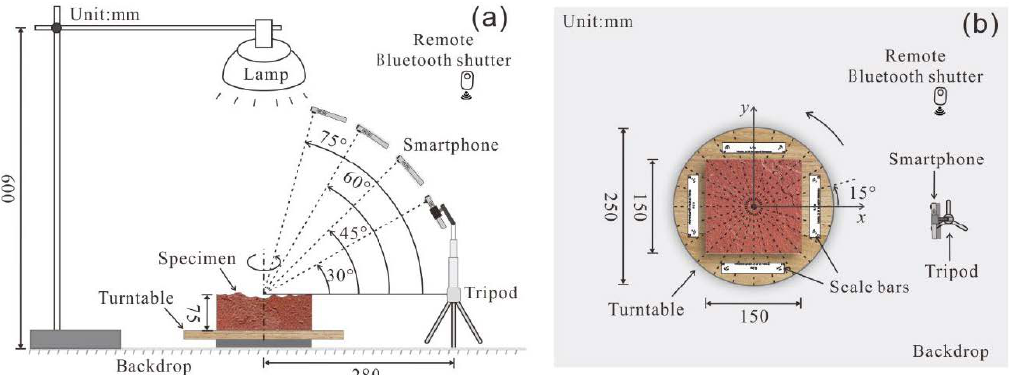
Figure 3. Schematic diagram of fixed smartphone capturing (FSC) mode ( a ) side view, ( b ) top